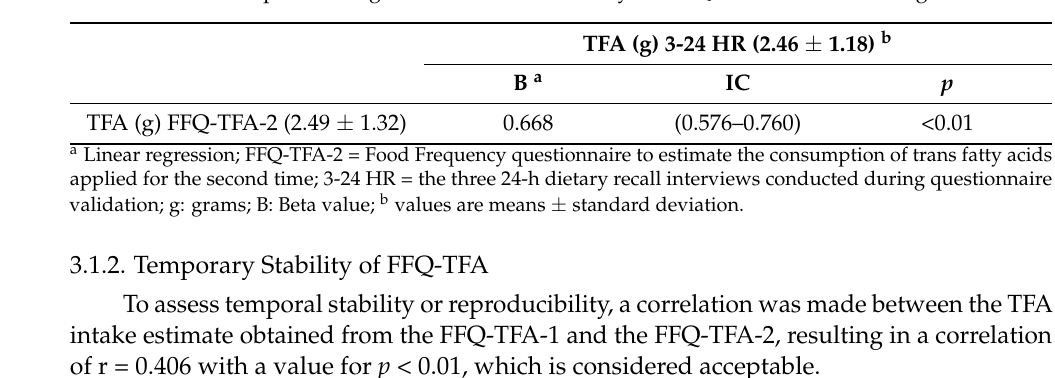
Figure 2. ( a ) Correlation between grams of TFA estimated by EPQ-TFA-2 and the average of the 3- 24 HR. ( b ) Bland–Altman plot of the estimated differences in TFA consumption between FFQ-TFA- 2 and 3-24 HR. ( c ) Bland–Altman plot of the estimated differences in TFA consumption between FFQ-TFA-1 and FFQ-TFA-2. Table 4. Relationship between grams of TFA estimated by the FFQ-TFA-2 and the average of 3-24